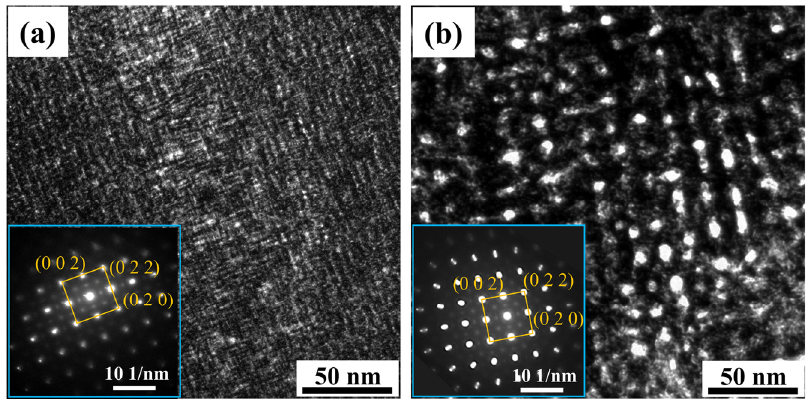
Figure 1. The TEM images and diffraction patterns in the matrix after aging at ( a ) 350 °C and ( b ) 450 °C.